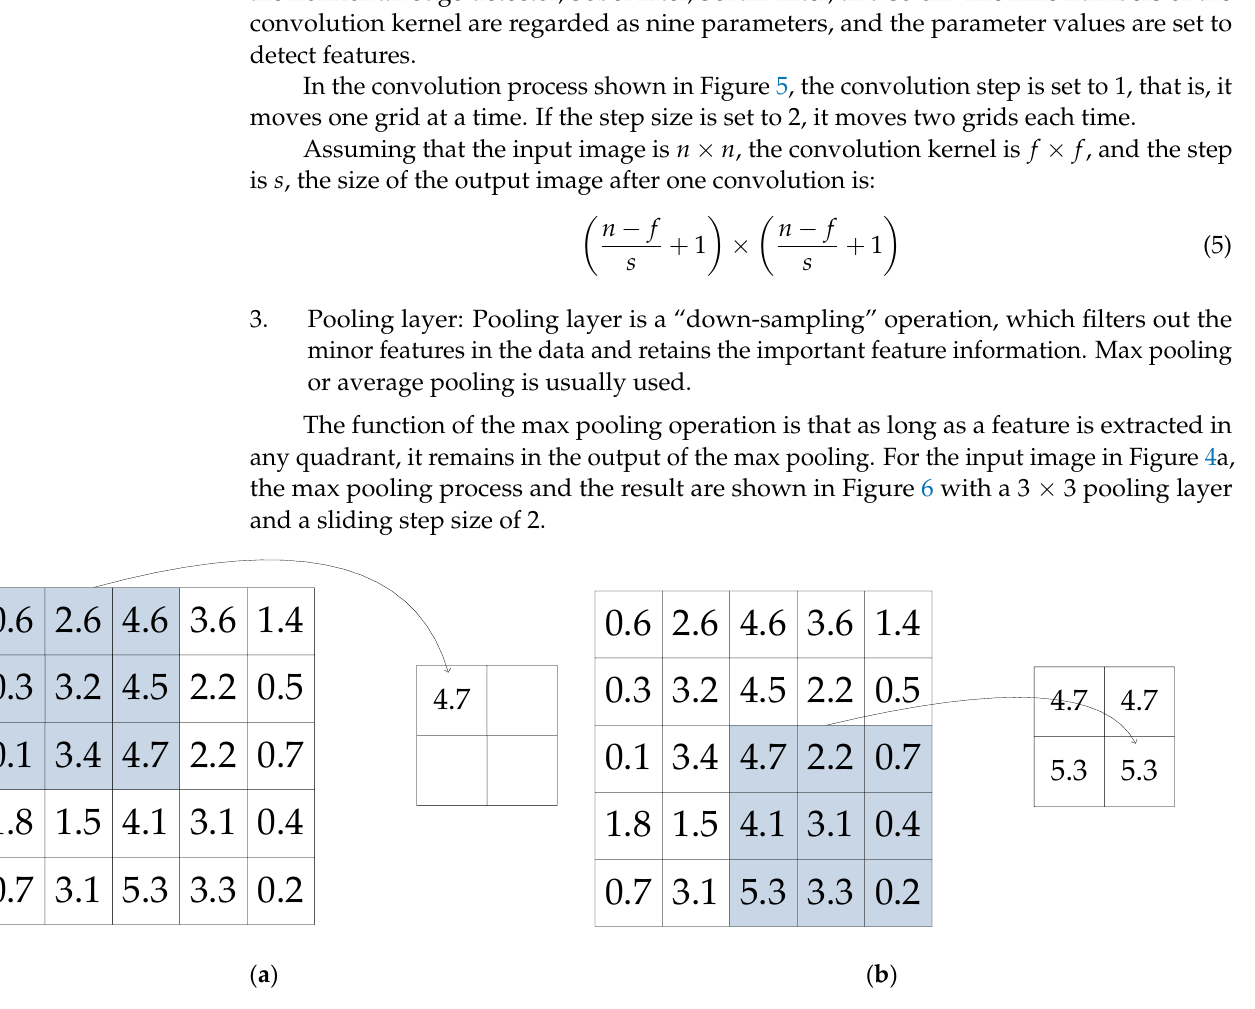
Figure 6. Pooling process with result of ( a ) the first pooling and ( b ) the last pooling. Equation (5) used to calculate the output size of the convolution layer is also applicable to calculate the max pooling output